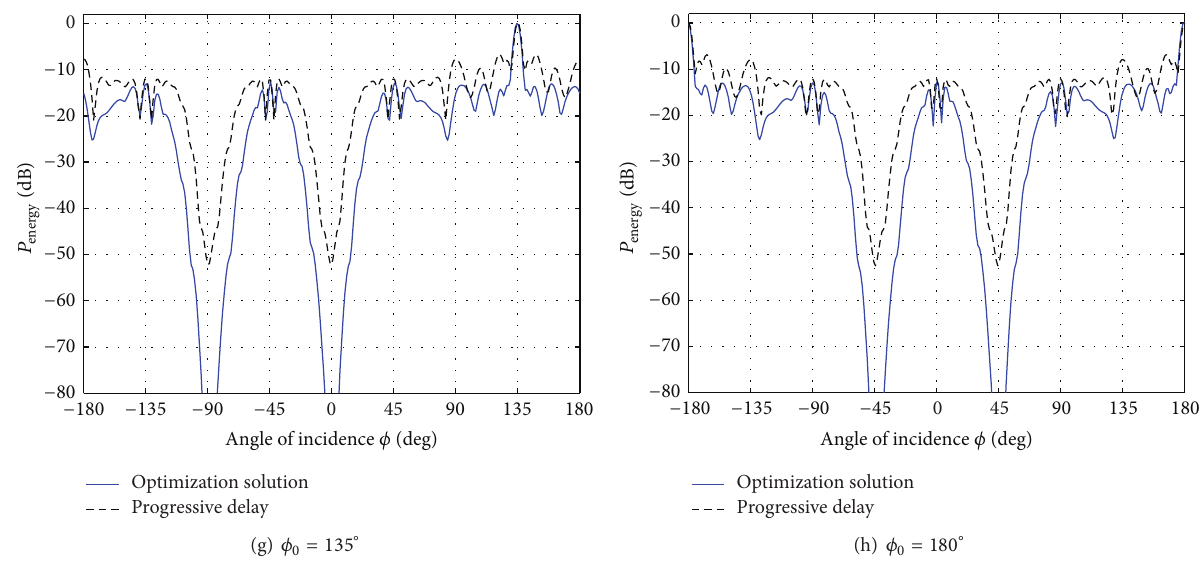
Figure 4: Comparison of the energy patterns between conventional case and optimized solution by DEMO/parent algorithm for (a) 𝜙 0 = = −90 ∘ , (c) 𝜙 = −45 ∘ , (d) 𝜙 = 0 ∘ , (e) 𝜙 = 45 ∘ , (f) 𝜙 = 90 ∘ , (g) 𝜙 = 135 ∘ , and (h) 𝜙 −135 ∘ , (b) 𝜙 0 0 0 0 0 0